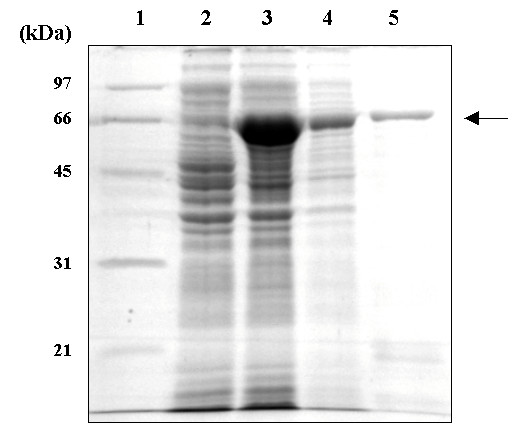
SDS-PAGE profiles of Os4bglu12 recombinant protein expressed in OrigamiB (DE3)E. coli after incubation in the presence of 0.3 mM IPTG, at 20°C for 8 h. Lanes: 1, standard marker (Bio-RAD); 2, total protein in E. coli cells containing pET32a(+) without an insert; 3, total protein of E. coli cells containing pET32a(+)/DEST-Os4bglu12; 4, soluble fraction of E. coli cells containing pET32a(+)/DEST-Os4bglu12; 5, purified Os4bglu12 recombinant protein. The arrow points to the position of thioredoxin fusion protein monomer.